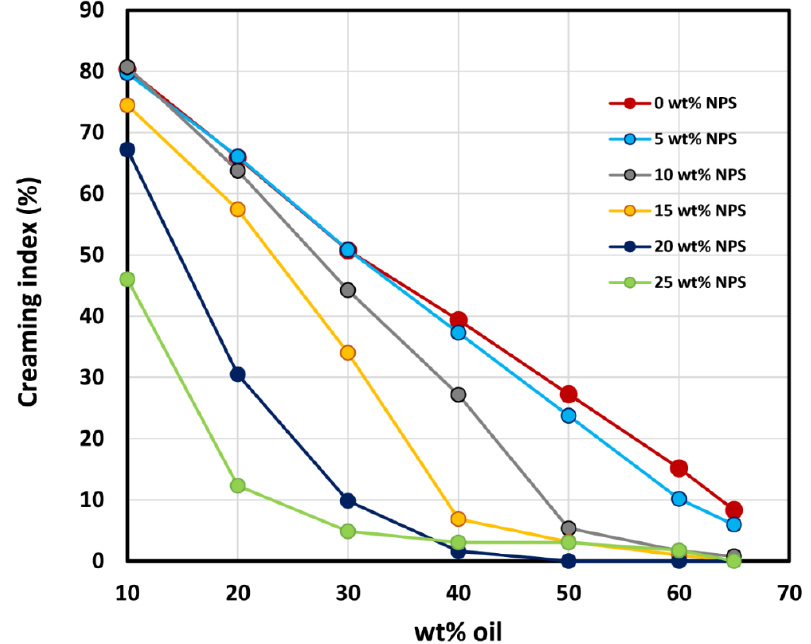
Figure 19. Percent creaming index of O/W emulsions when left unstirred for several weeks.